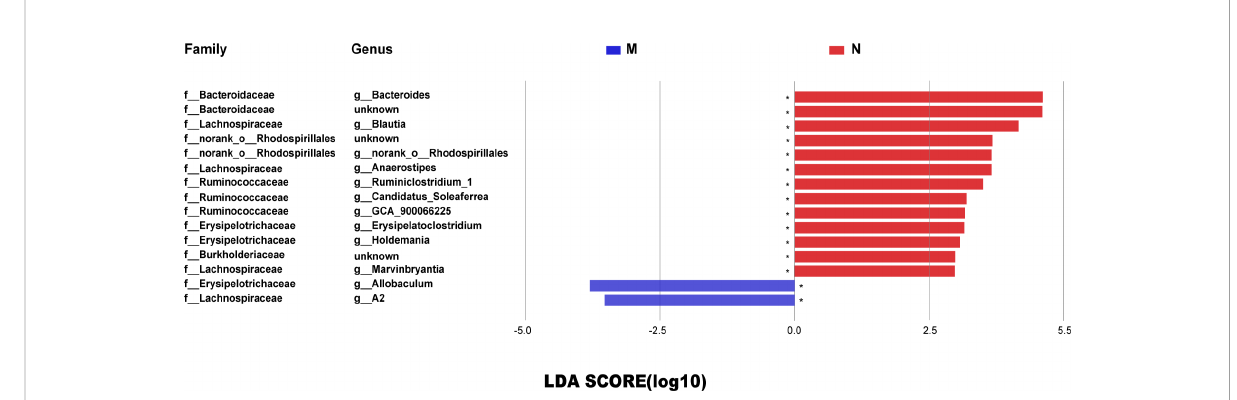
FIGURE 4 The LDA score identi fi ed the size differentiation between the N and M groups with a threshold value of 2. *0.01< P ≤ 0.05. The relative abundances of the Allobaculum and A2 genera in the M group increased, while the relative abundances of Bacteroides, Bacteroidaceae,